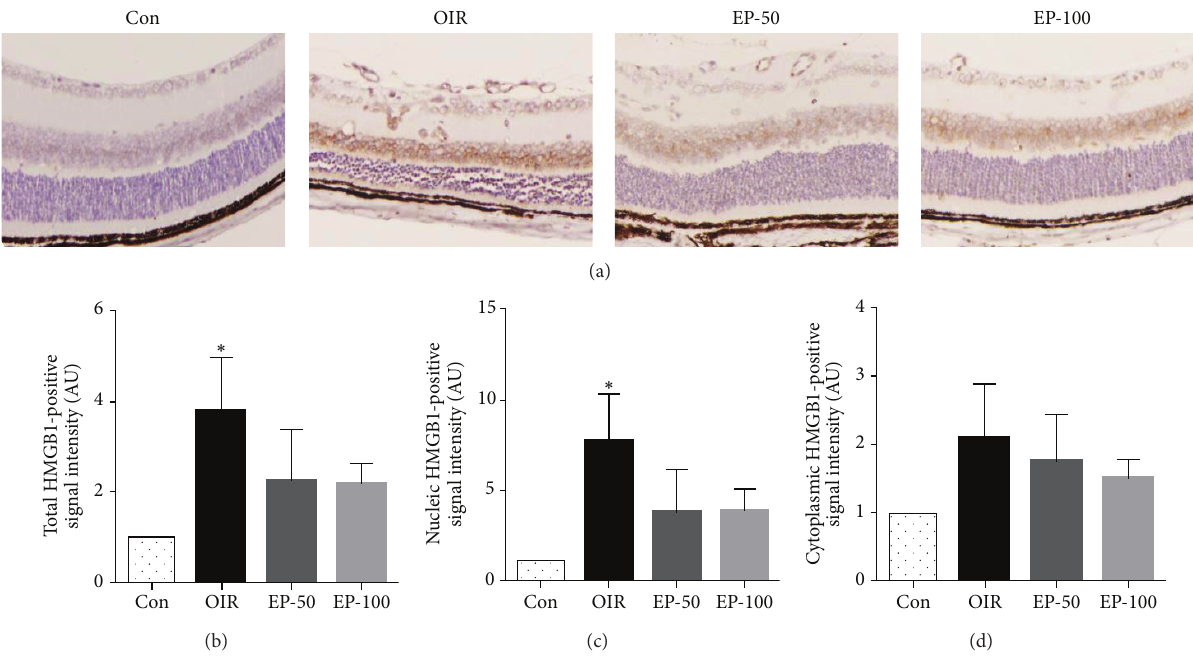
Figure 4: The effect of EP on retinal of HMGB1 expression in OIR mice. (a) Representative photomicrographs of retinal sections labeled with an anti-HMGB1 antibody. Retinas from control (Con), OIR (OIR), 50 mg/kg EP-treated (EP-50), and 100 mg/kg EP-treated (EP-100) mice. (b) Morphological quantitative analyses of nuclei (c) and cytoplasm (d) HMGB1-positive signal intensity. The data are expressed as the mean ± SE (𝑛 = 6) . ∗ 𝑃 < 0.05 versus the Con